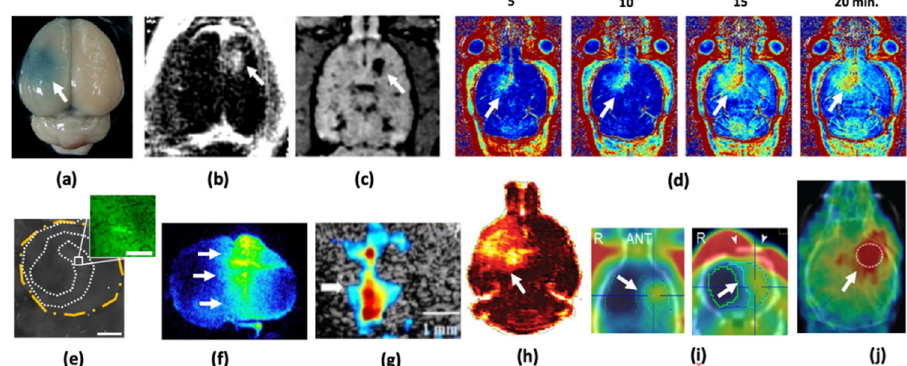
Figure 1. Representative images demonstrating the use of various modalities to monitor FUS-BBBO: ( a ) staining with Evans blue dye (arrow) [40], ( b ) TI-weighted CE-MRI [33], ( c ) T2-weighted CE-MRI [41], ( d ) MRI T1 relaxometry to sequentially follow the distribution of penetrating Gd-DTPA [42], ( e ) fluorescent-tag dextran penetration using optical microscopy [43], ( f ) autoradiography [39], ( g ) dynamic ultrasound imaging [44], ( h ) DCE-MRI [37], ( i ) 99m Tc-DTPA SPECT [39], and ( j ) 68 Ga PET [45] (min. = minutes, ANT = anterior; Adapted from Chen et al. (2019)).